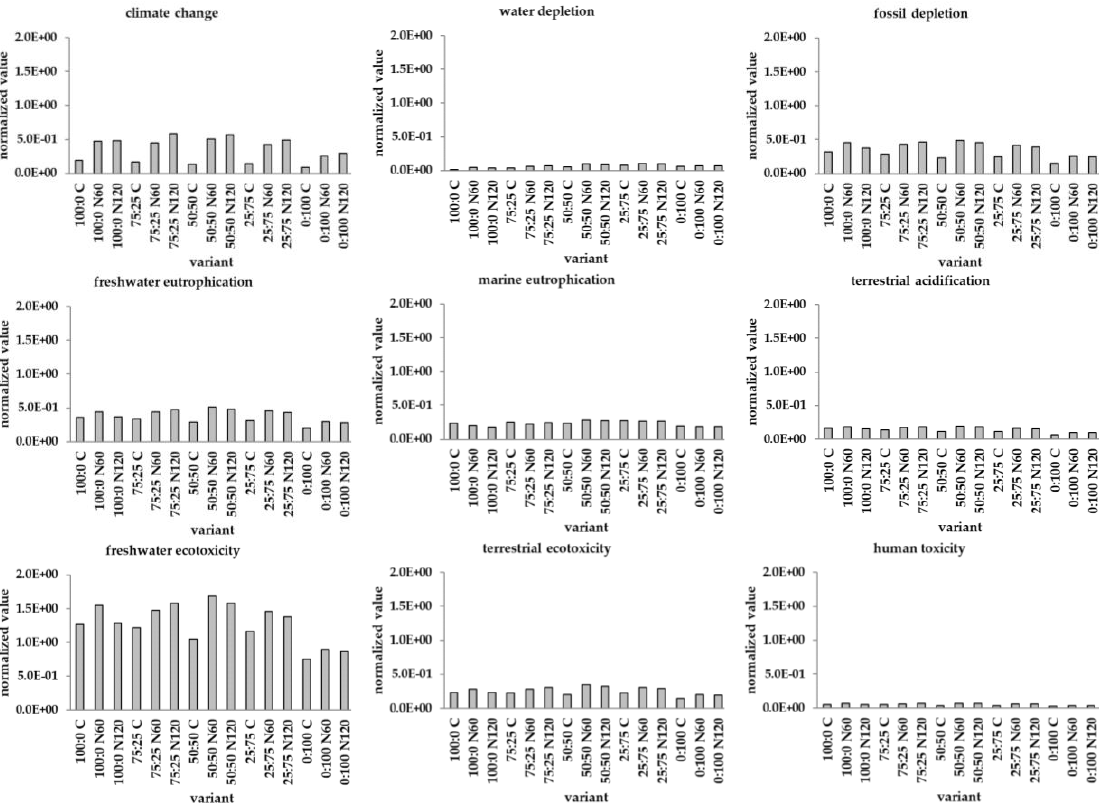
Figure 4. Trends of the environmental impact per land demand for generating the same grain N yield; C = Control; N60 = variant with input of 60 kg N ha − 1 ; N120 = variant with input of 120 kg N ha − 1 ; Sowing ratios of oat:pea (%:%): 100:0, 75:25, 50:50, 25:75, and 0:100; SimaPro 9.1.1.1 software; ReCiPe 2016 Midpoint (H) V1.05/World (2010) H; Cut-off System Model approach; Normalization model .